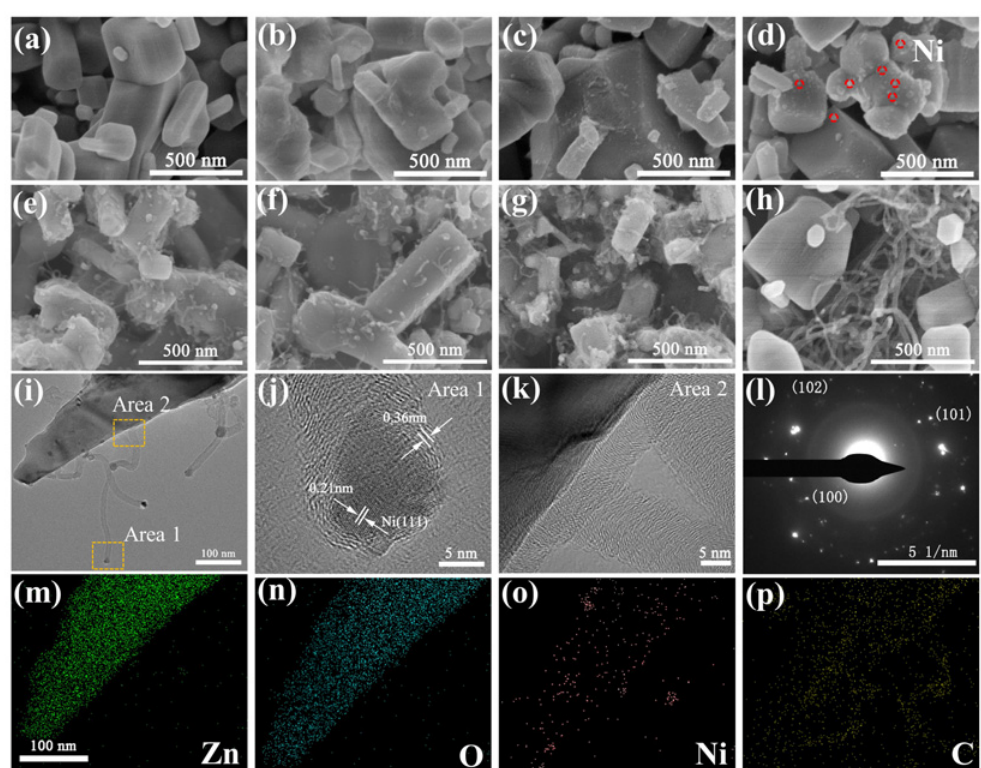
Fig. 3 SEM images of precursors: (a) pure ZnO, (b) Ni(OH) 2 /ZnO, (c) NiO/ZnO, and (d) Ni/ZnO. (e–g) SEM images of CNTs/ZnO composite powders with in-situ grown CNTs synthesized using different mass ratios of Ni catalysts: 1.5, 1.75, and 2.0 wt%; (h) SEM image of CNTs/ZnO composite powders mixed with commercial CNTs by ultrasonic dispersion; (i–k) TEM and HRTEM images of 2.0% Ni–CNTs/ZnO sample; (l) selected area electron diffraction pattern; and (m–p) EDS elemental mappings of 2.0% Ni–CNTs/ZnO